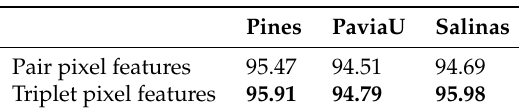
Table 7. Classification performance of the extended framework using CNN 2 -lite as subnetworks with triplet pixel features (OA shown in